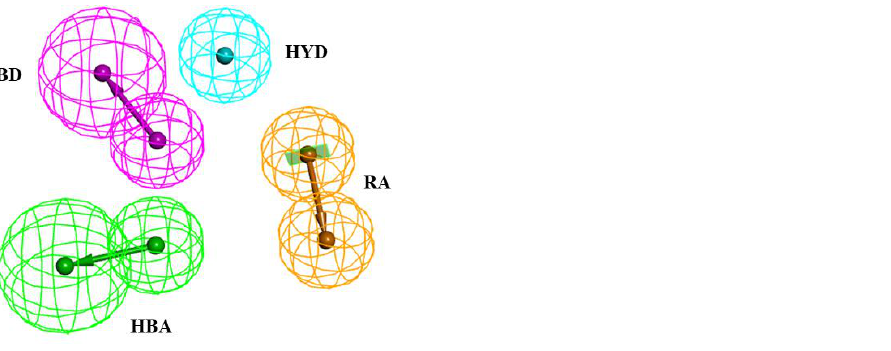
Figure 1. The best HypoGen Pharmacophore model (Hypo1). Green color represents HBA, purple color represents HBD, blue color represents HYD, brown color represents RA.